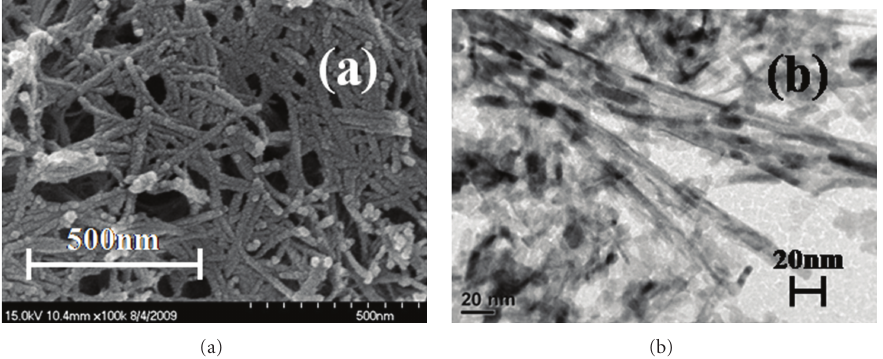
Figure 2: SEM and TEM images of TNT powders calcined for 30min at 723K in O 2